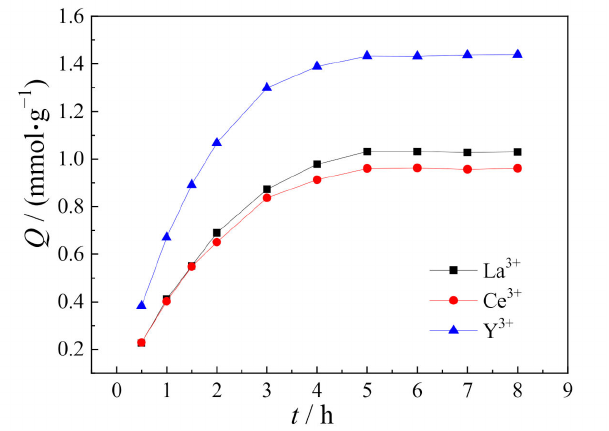
Figure 6. Effect of contact time on the adsorption capacity of PAMHA. ( C 0 = 0.01 mol · L − 1 , 45 ◦ C, pH for La 3+ , Ce 3+ , and Y 3+ were 1.5, 3.0, and 2.0,